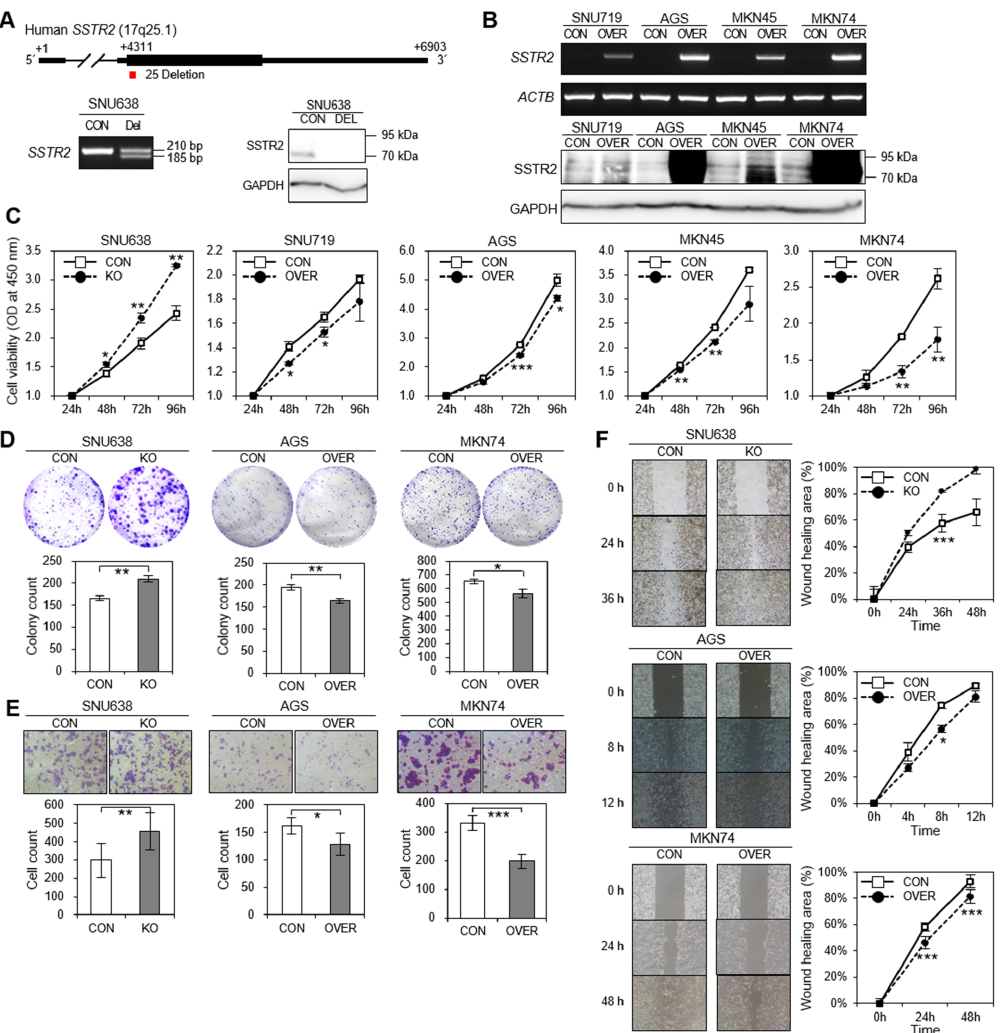
Figure 4. In vitro assays for SSTR2 -KO and ectopic SSTR2 expression. ( A ) Establishment of SSTR2 - KO cells. Upper panel shows SSTR2 gene structure and position of 25 bp deletion in coding sequence. PCR analysis shows 25 bp deletion (185 bp) in SSTR2 -KO SNU638 cells by CRISPR/Cas9 system (left in bottom). SSTR2 expression was compared between control and SSTR2 -KO cells by Western blot analysis (right in bottom). GAPDH was used as an internal control. ( B ) Establishment of ectopic SSTR2 -expressing ( SSTR2 -OVER) cells. SSTR2- expression vector with a lentiviral was transfected into GC cell lines, such as SNU719, AGS, MKN45, and MKN74. SSTR2 expression was examined in control and ectopic SSTR2 -OVER cells by RT-PCR (upper) and by Western blot analysis (lower), respectively. ACTB or GAPDH was used as an internal control, respectively. ( C ) Cell viability assay. Relative viabilities of SSTR2 -KO SNU638 or SSTR2 -OVER SNU719, AGS, MKN45, and MKN74 cells over 4 days were measured using a CCK-8 kit and compared to the empty vector control (CON). ( D ) Colony formation assay. SSTR2 -KO SNU638 or SSTR2 -OVER AGS and MKN74 cells were plated on six-well plates at 1 × 10 3 cells per well. After 2 weeks, colonies were stained with crystal violet and counted. ( E ) Migration assay. SSTR2 -KO SNU638 or SSTR2 -OVER AGS and MKN74 cells were plated on transwell chambers at 2 × 10 4 cells per well. After 18–22 h, transwell membranes were stained with crystal violet and cells were counted. ( F ) Wound-healing assay. Gap closure assay with SSTR2 -KO SNU638 or SSTR2 -OVER AGS and MKN74 cells were performed at a density of 1 × 10 5 cells. Scale bar, 100 µ m. * p < 0.05, ** p < 0.01, *** p < 0.001 versus control (CON)